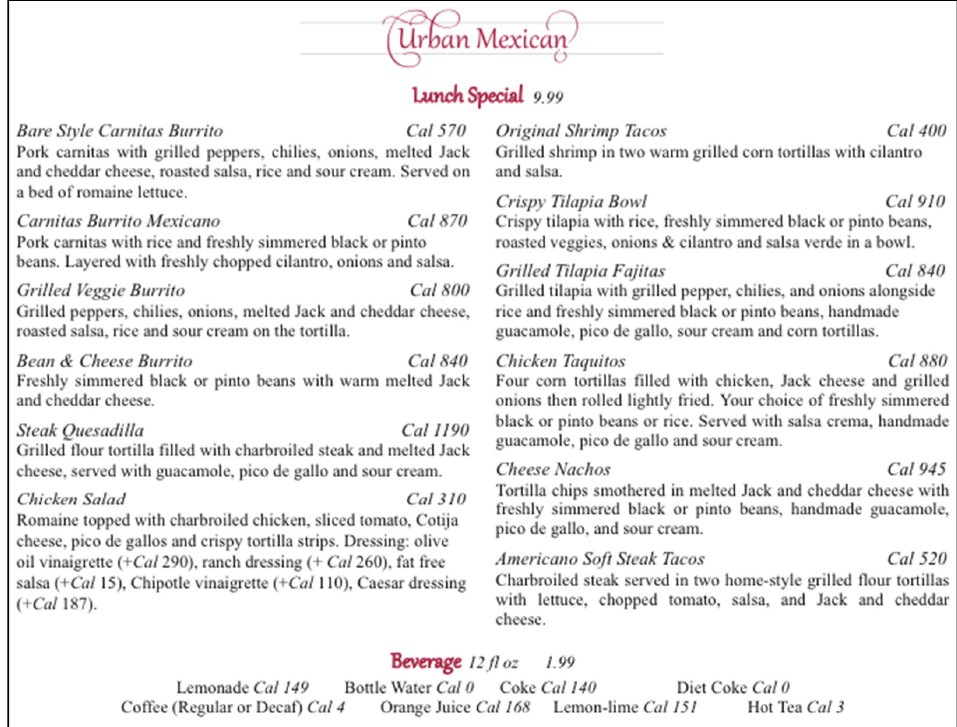
Figure A10. Urban Mexican First and Last Menu.